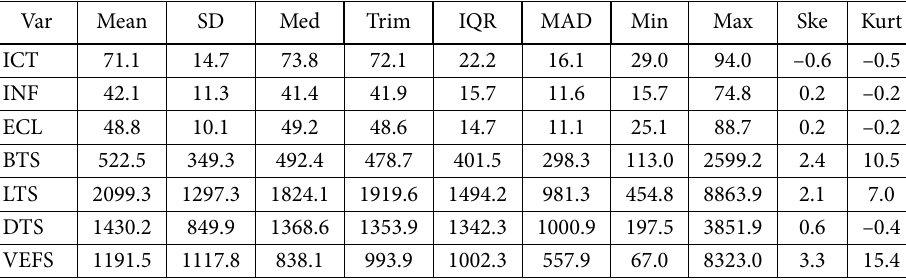
Table 3. Descriptive analysis